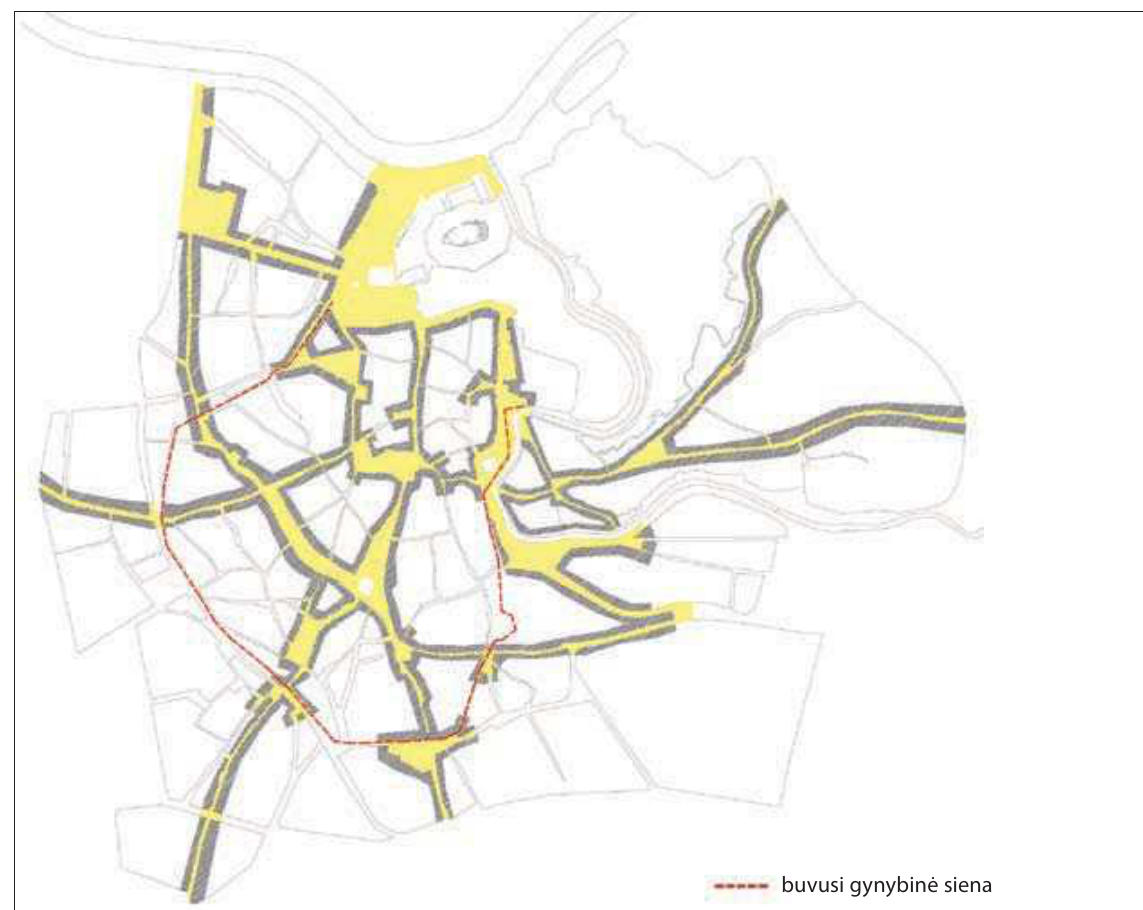
buvusi gynybinė